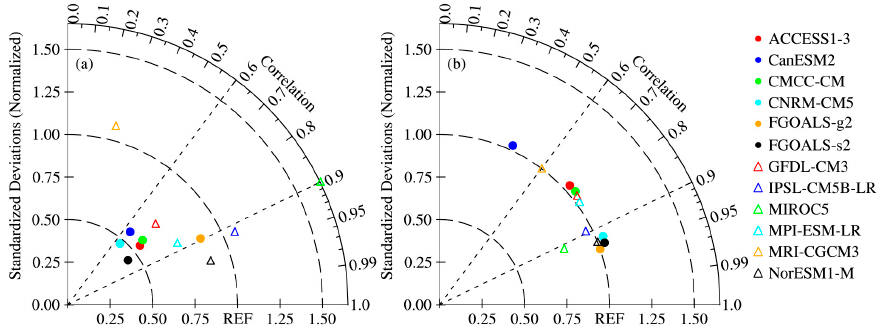
Figure 8. Taylor diagrams for the ( a ) first and ( b ) second EOF modes.